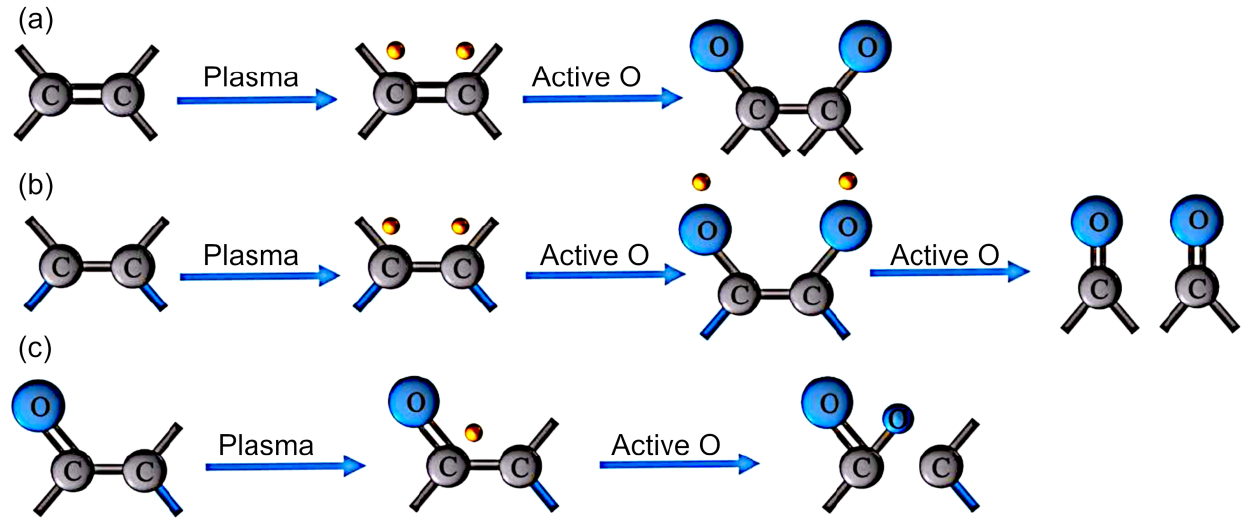
Figure 11. Possible mechanism of surface group oxidation by plasma treatment: ( a ) generation of C–O bonds, ( b ) generation of C=O bonds, ( c ) generation of O–C=O bonds. Reproduced from Lu et al. (2019) [30] under conditions of the CC BY license.